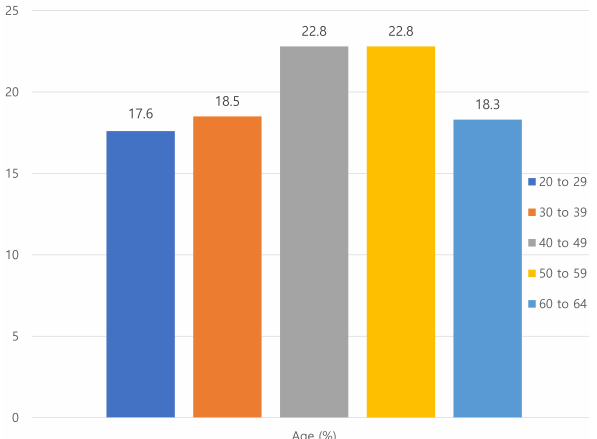
Fig. 3. Occupation of study participants. (%)